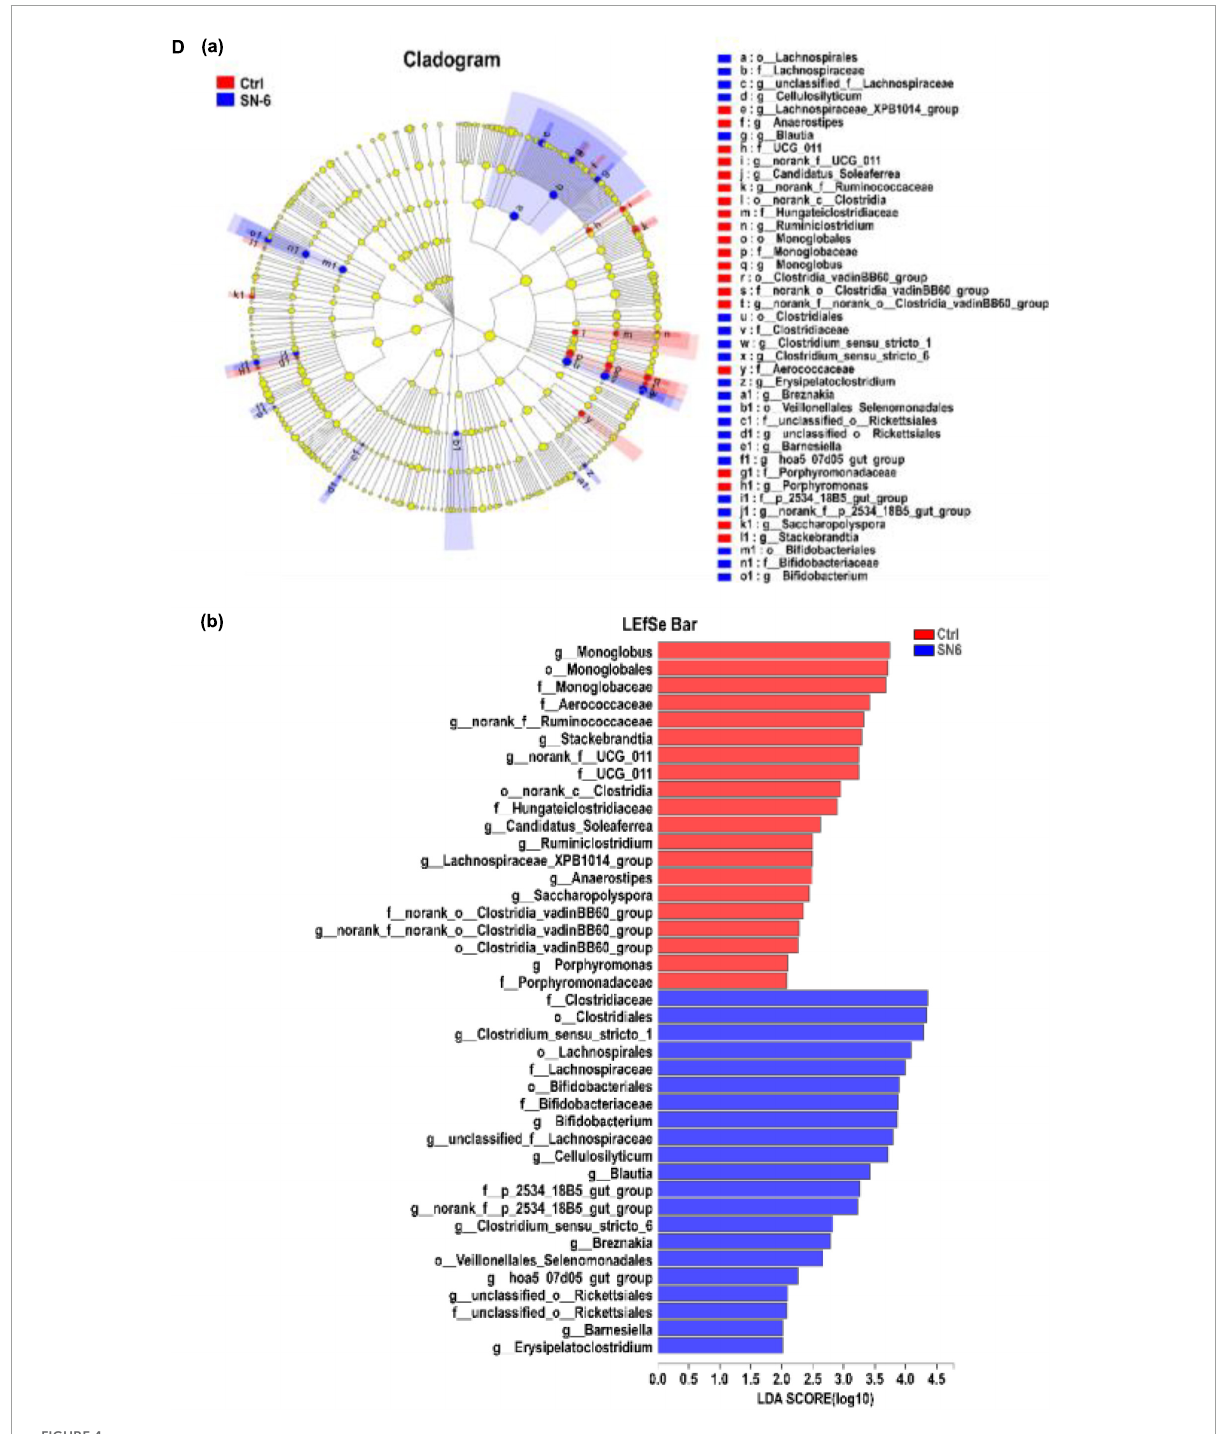
FIGURE4 SN-6 alters the fecal microbiota composition of Simmental. (A) PCoA score plot of fecal microbiota based on OTU abundance. (B) Bacterial taxonomic profiling of fecal microbial community at phylum level. (C) Significant analysis of species difference at the genus level. * p < 0.05, ** p < 0.01, *** p < 0.001. (D) Diversity analysis of LEfSe multistage species. (a) Cladogram. The circles radiating from the inside to the outside represent the taxonomic level from phylum to genus. Each small circle represents a classification at the same level, and the diameter of the small circle is positively related to its abundance. The species without significant differences are uniformly colored yellow. The red node represents the relatively important microbe in the control group, and the blue node represents the relatively important microbe in the SN-6 group. The species name is present on the right. (b) Histogram of LDA value distribution. The species with LDA score greater than 3.0 are biomarkers with a statistical difference. The length of the histogram represents the influence of the species with a significant